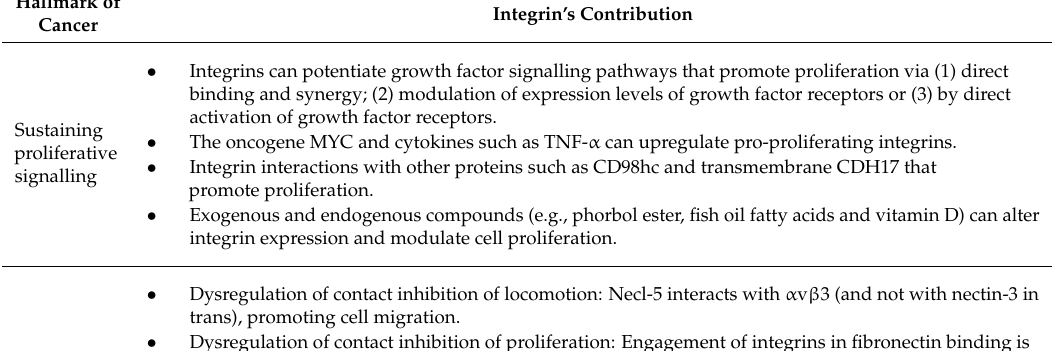
Table 2. Summary of the contributions of integrins in the Hallmark of Cancer. (The reader will find all the references in the main